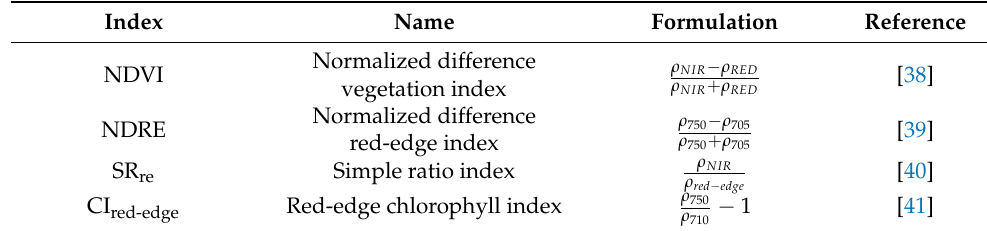
Table 6. Vegetation indices evaluated in this study.